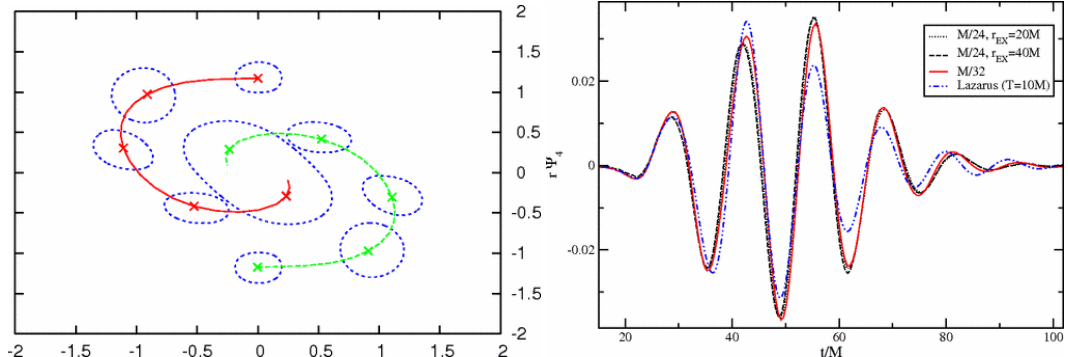
Figure 5. Early example of a merging binary black hole simulation. Positions of the apparent horizons (left) with time, t = 0,5, 10,15,and 20 M . The line shows the trajectories of centroids of the individual apparent horizons (dashed). Gravitational wave signal (right) for simulation runs of different resolution. Figures reprinted from Reference [108] (doi:10.1103/PhysRevLett.96.111102) with kind permission